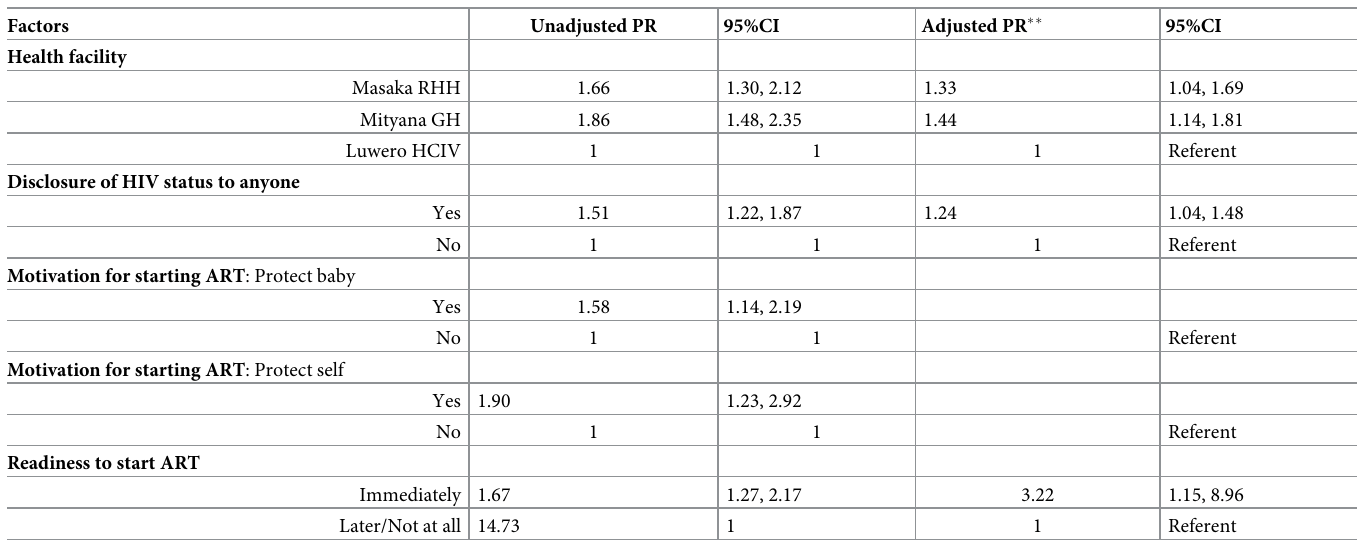
Table 8. Factors associated with early adherence to Option B+ ART (n =